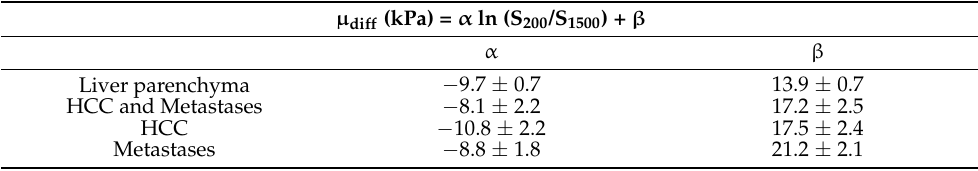
Table 4. Virtual stiffness calibration parameters (estimated using the whole patient cohort).